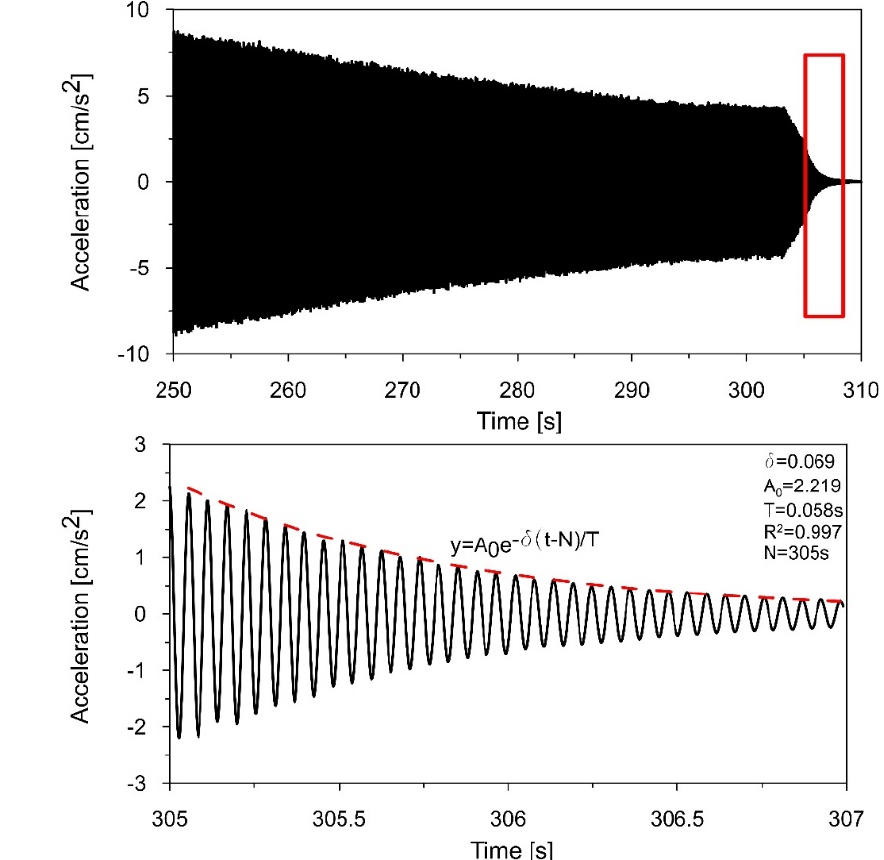
Figure 17. ( a ) The acceleration − time history filtered around f 1 = 17.184 Hz; ( b ) the decrease in amplitudes (305–307 s) that served to estimate the logarithmic decrement of damping d 1 = 0.069. Then, to estimate the logarithmic decrement of damping corresponding to the second natural frequency, the recorded acceleration-time history of the model vibration in the range of 71–75 Hz (see Figure 16a) was filtered around the first frequency of 73.263 Hz, using a narrow-band filter with a width of 0.2 Hz (73.15–73.35 Hz). Figure 18 presents the acceleration-time history of the filtered signal, showing the decrease in the vibration amplitude (406–407 s). Based on the declining amplitudes, the logarithmic decrement of damping δ 2 = 0.104 and the damping ratio ξ 2 = 1.66%, corresponding to the second natural frequency, were